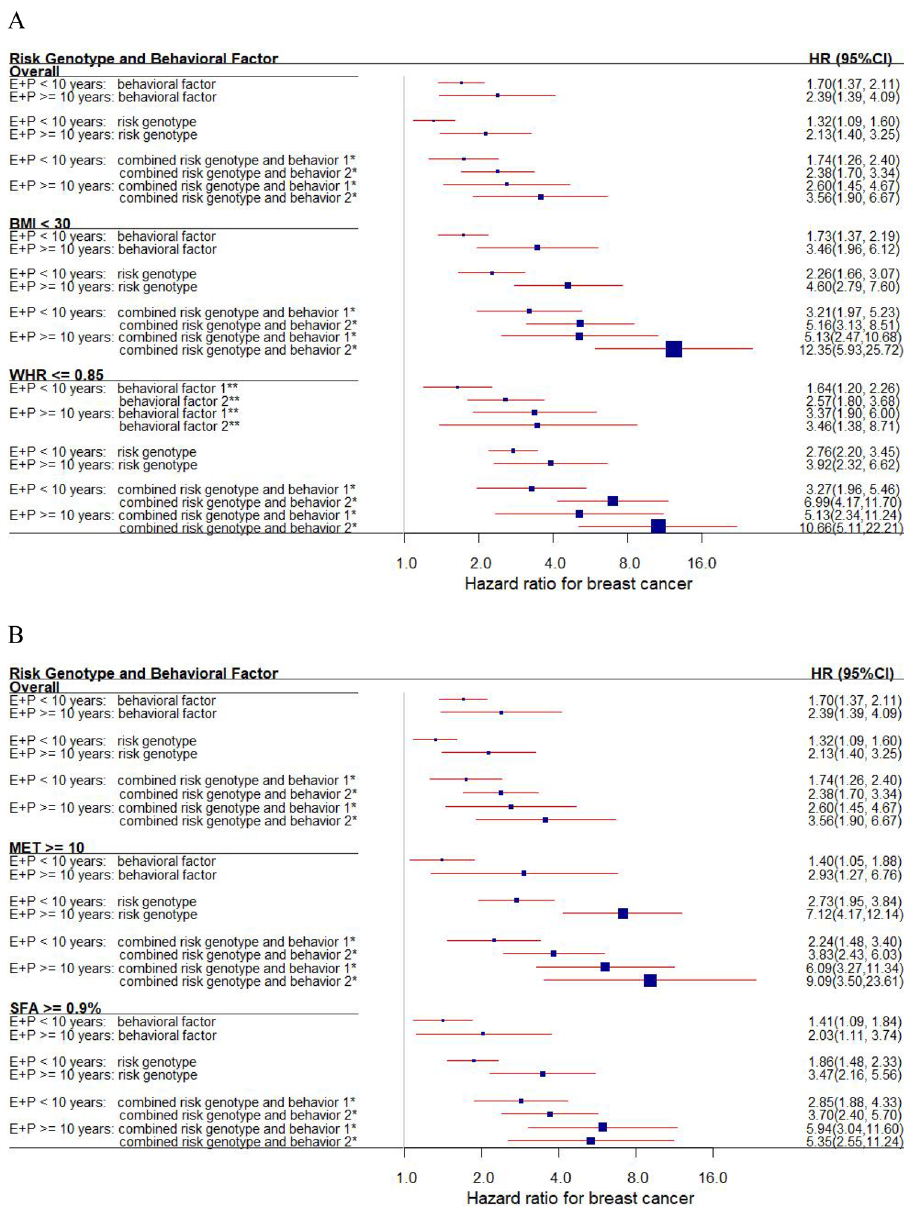
independent and combined effect of risk behaviors and genotypes on breast cancer risk, jointly testing with E + P use, presented as the 95% CIs (indicated with red lines) and the estimates (proportional to the size of the blue squares). BMI, body mass index; CI, confidence interval; E + P, E + P, exogenous estrogen + progestin; HR, hazard ratio; MET, metabolic equivalent; SFA, saturated fatty acids; WHR, waist-to-hip ratio. * The combined number of risk genotypes and behavioral factors was based on risk genotypes defined as 0 (low risk: none or < total number of risk alleles) and 1 (high risk: combined all risk alleles) and based on behavioral factors defined as 0 (low risk: null risk behavior) and 1 (high risk: 1 or more risk behaviors). The ultimate number of risk genotypes combined with behavioral factors was defined as 0 (low risk for genotypes and behaviors), 1 (either high risk for genotypes or behaviors), and 2 (both high risk for genotypes and behaviors). ** The number of behavioral factors was defined as 0 (null risk behavior) vs. 1 (1 risk behavior) vs. 2 (2 or more risk